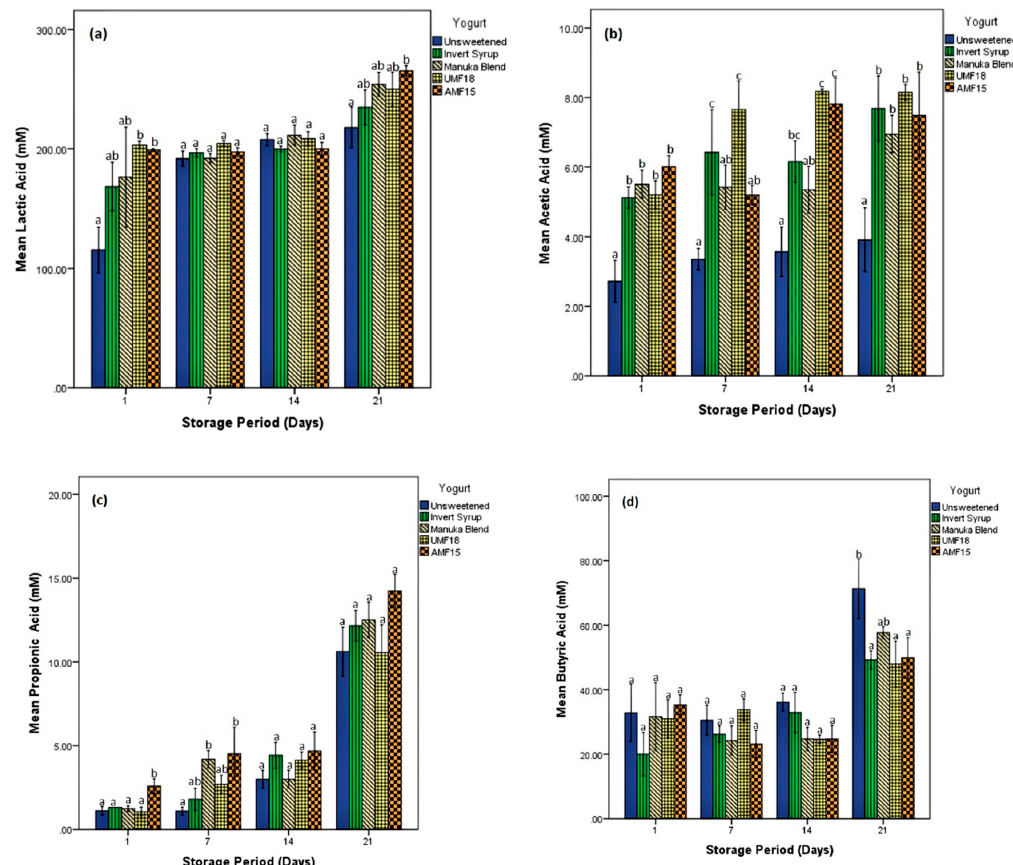
Figure 2. Concentration (mM) of ( a ) lactic acid ( b ) acetic acid ( c ) propionic acid and ( d ) butyric acid produced in yogurts with three di ff erent types of Manuka honey (Blend, UMF TM 18 + and AMF TM 15 + ) invert syrup, and unsweetened control, over the refrigerated storage period (21 days). Different lowercase letters indicate significant di ff erences ( p < 0.05) among the yogurt samples (on that particular day). Error bars represent standard error of means (±1 SE).